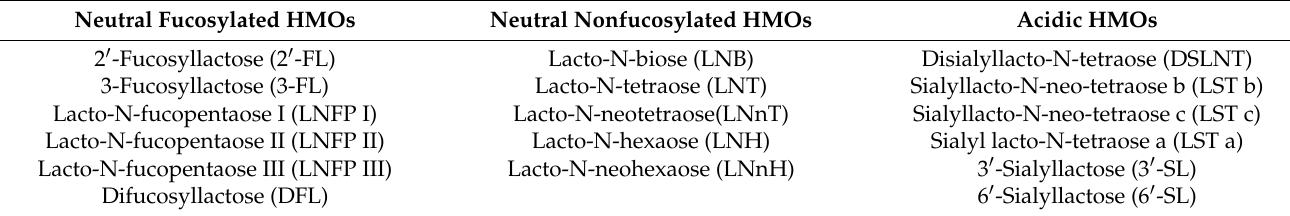
Table 2. Examples of the three different fractions of HMOs, showing neutral (fucosylated and nonfucosylated) and acidic